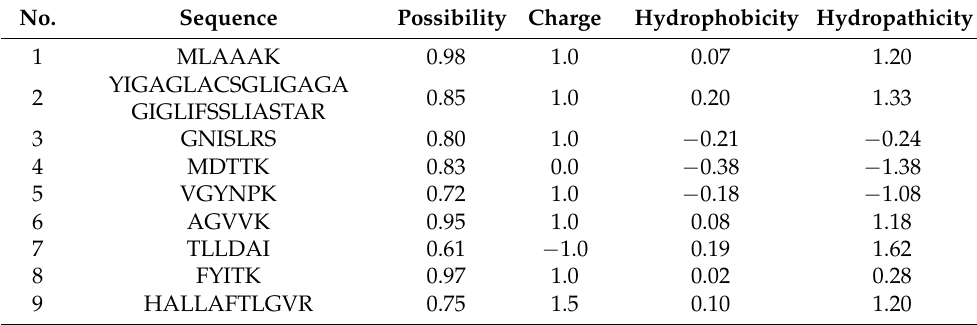
Table 1. Properties of Selected Peptides for Synthesis.